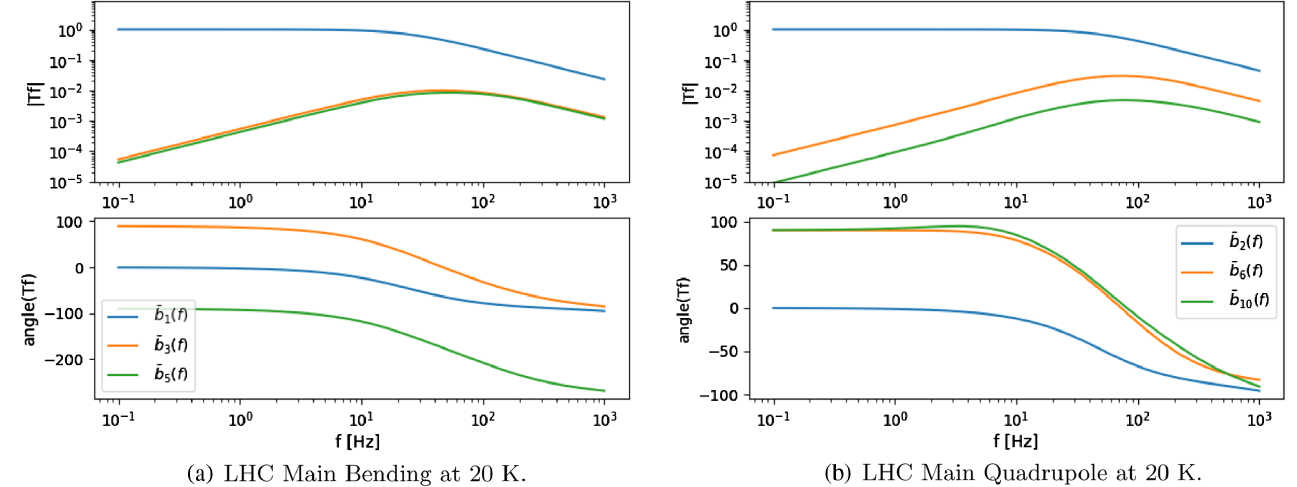
FIG. 14. AC multipole analysis for the beam screens of the LHC Main Dipoles.